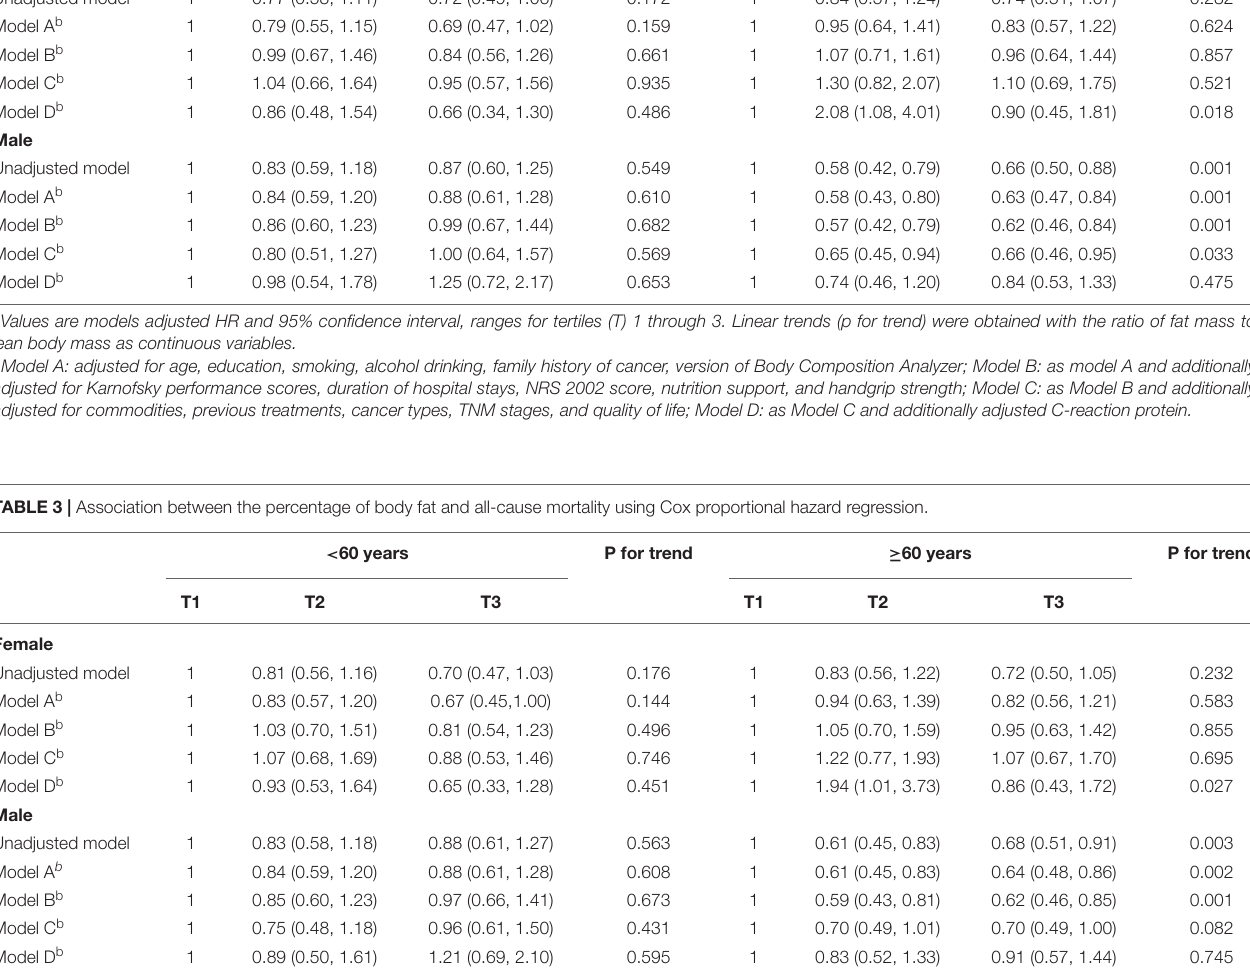
< 60 years P for trend ≥ 60 years P for trend